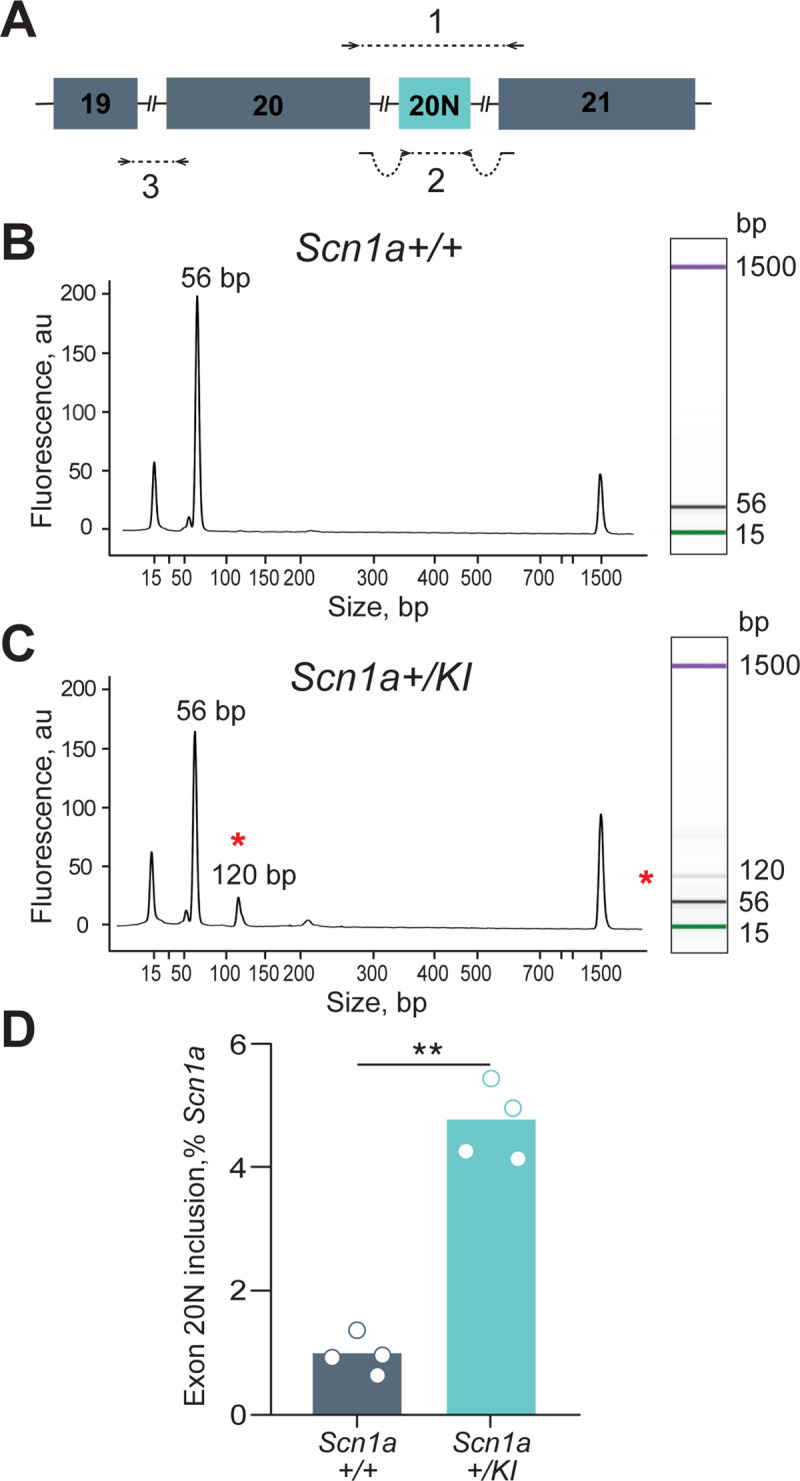
Increased inclusion of Exon 20N in Scn1a+/KI brains.(A) The positions of qPCR amplicons to quantify Scn1a mRNA transcripts. Amplicon 1 detects two isoforms (56bp and 120bp) of the Scn1a transcript, with the longer isoform reflecting exon 20N inclusion. Amplicon 2 quantifies only the Exon 20N-containing transcript. Amplicon 3 quantifies the total Scn1a mRNA levels including the transcript with Exon 20N. (B) Bioanalyzer evaluation of RNA from Scn1a+/+ mouse brain amplified with amplicon 1, showing a single Scn1a peak at 56 bp. The peaks at 15-bp and 1500-bp are size markers recommended and supplied by the manufacturer. (C) Bioanalyzer evaluation of RNA from Scn1a+/KI mouse brain amplified with amplicon 1, showing a second peak at 120 bp, representing inclusion of exon 20N. The 120-bp amplicon containing the 64-bp exon 20N is denoted with a red asterisk. (D) Scn1a+/KI mice had increased levels of the exon 20N–containing Scn1a transcript, measured using amplicon 2. The levels of exon 20N transcript (amplicon 2) expressed as a percentage of the total Scn1a levels (amplicon 3) using the formula (amplicon 2 levels)/(amplicon 3 levels)*100. (n = 4, 11.64 ± 2.90 months, Student's unpaired t-test, p = 2e-4). **p < 0.01.